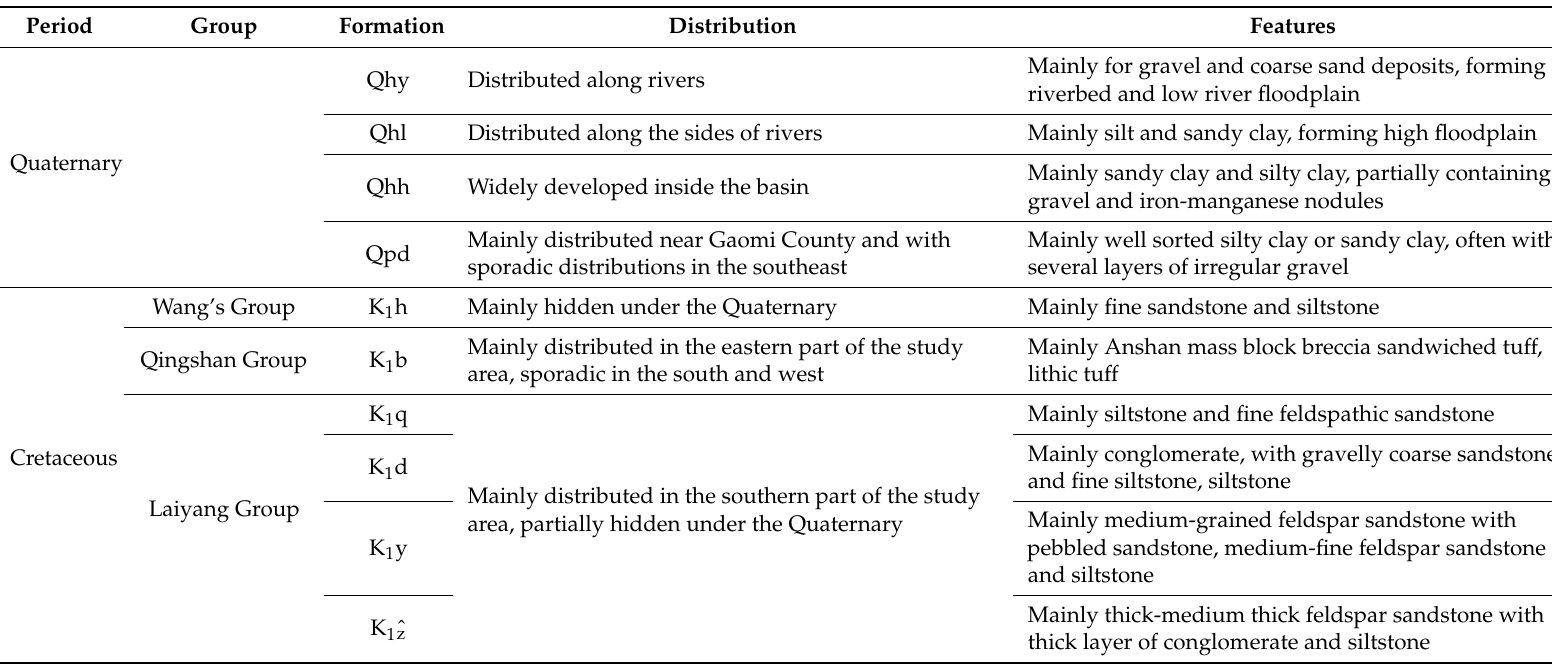
Table 2. The main stratum and lithology features of the Jiaolai Basin, Jiaodong Peninsula, eastern China